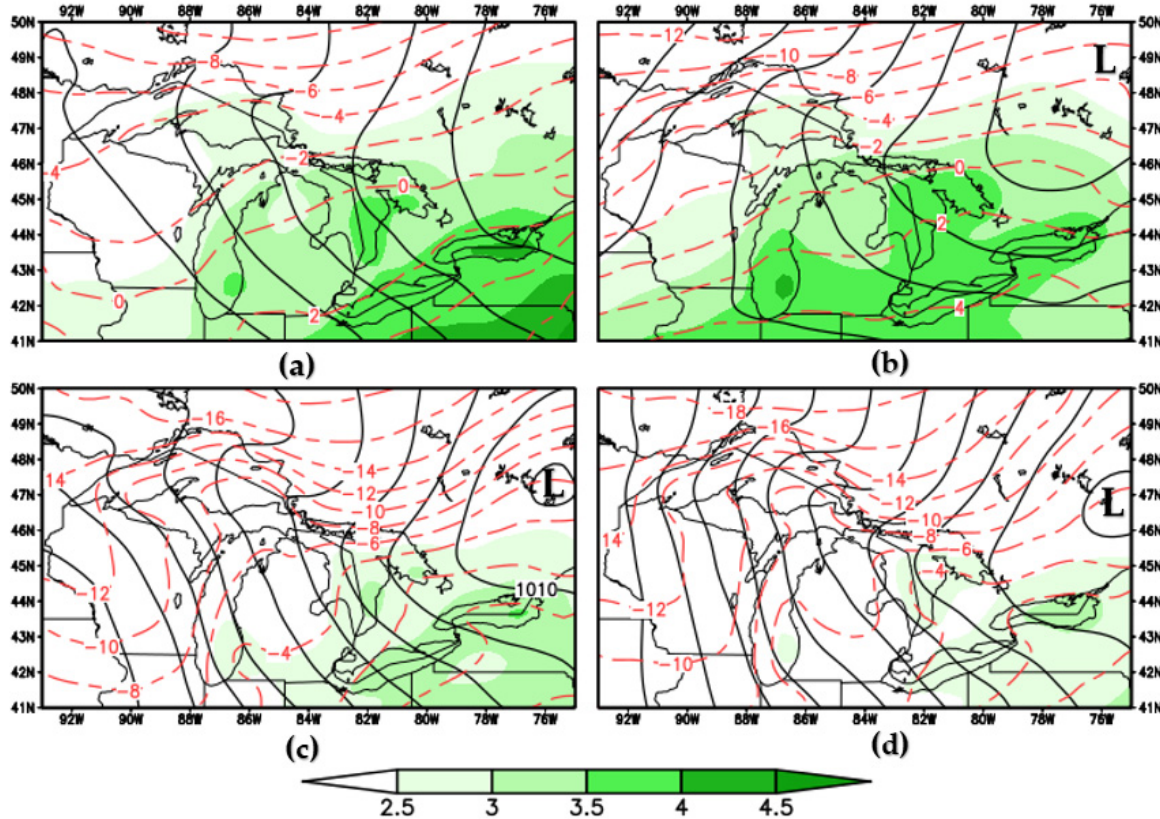
Figure 9. MSLP (solid black contours; mb), 1000 mb temperature (dashed red contours; °C), and 2-m specific humidity (shaded green; g kg − 1 ) for Cluster 1 ( a ), Cluster 2 ( b ), Cluster 3 ( c ), and the LES composite ( d ) while the clipper was located at 75° W.